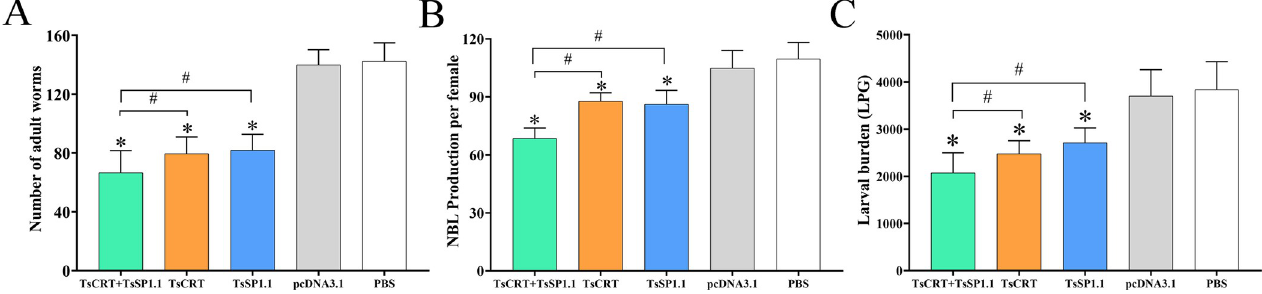
Fig 10. Immune protection of vaccination of mice with TsCRT +TsSP1.1, TsCRT and TsSP1.1 following 300 T . spiralis larval challenge. A: Intestinal adult worm burdens. B: The in vitro production of newborn larvae (NBL) deposited by each female in 72 h (n = 30). C: Muscle larvae burden (larvae per gram, LPG). The worm burdens are presented as mean ± SD from ten animals per group. � P < 0.001 compared to the PBS group. # P < 0.001 compared among various immunization